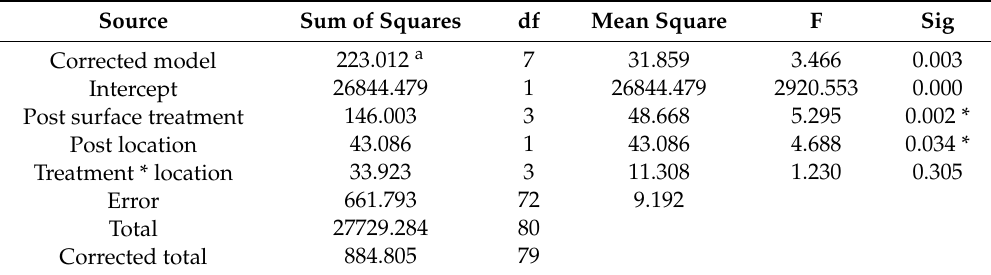
Table 1. Results of a two-way ANOVA with post surface treatment and post location as the independent variables and debonding force as the dependent variable. Source